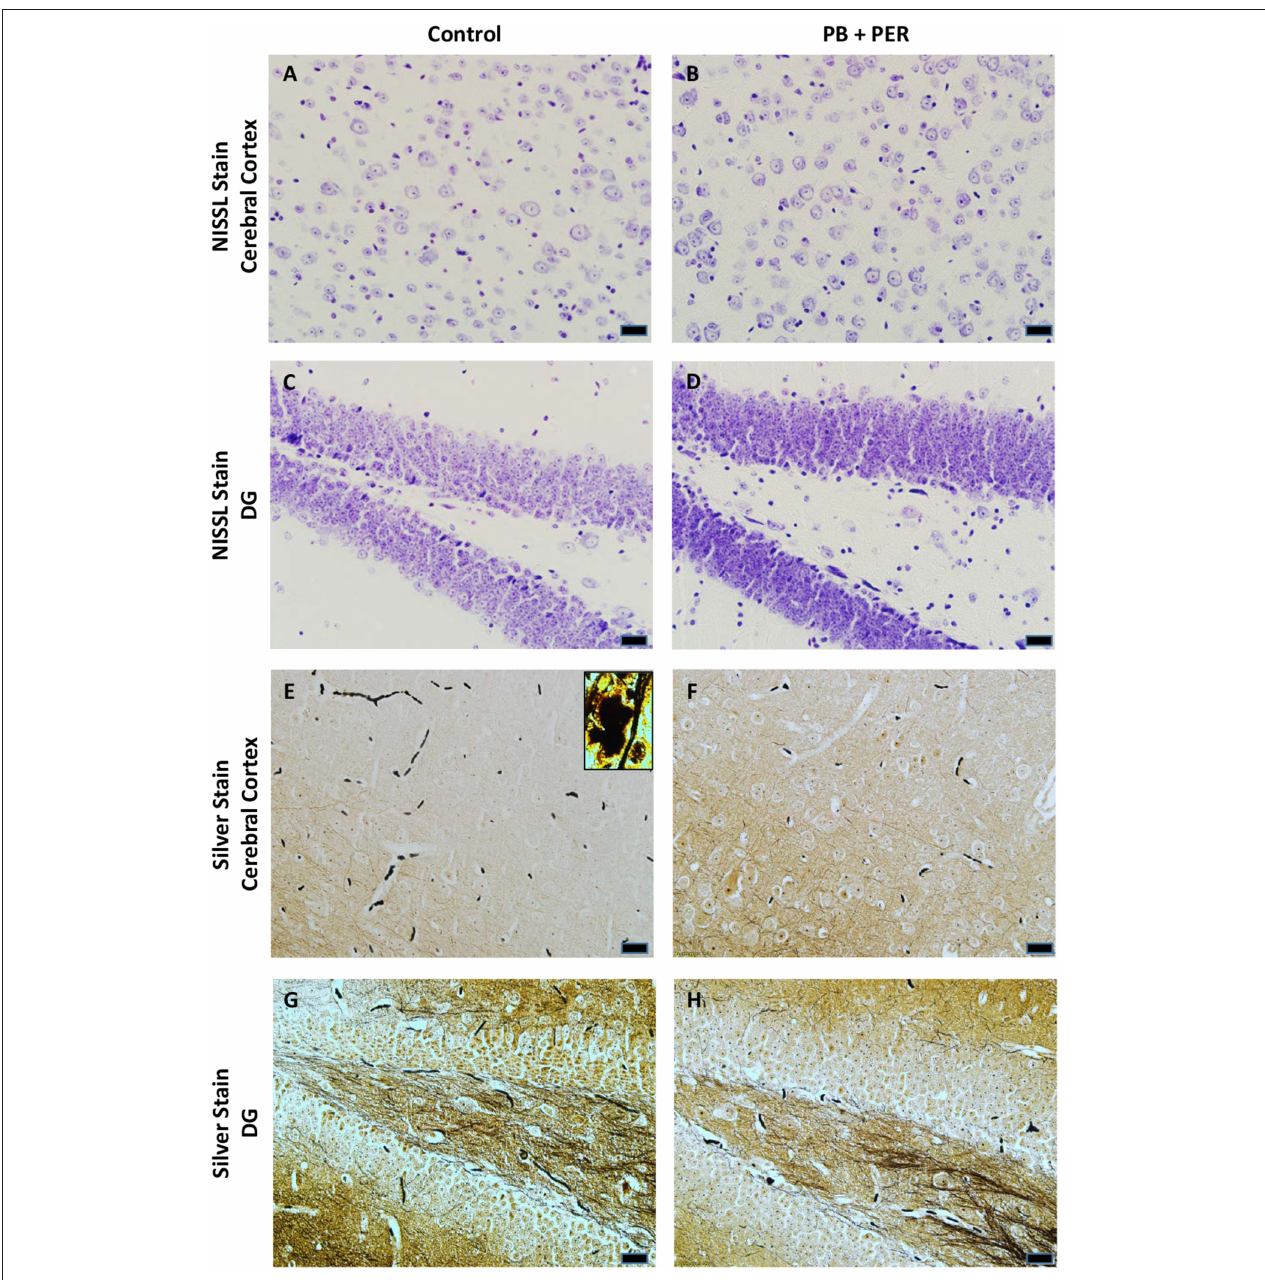
FIGURE 12 | No alterations in cell morphology detected 22.5 months post exposure to PB + PER. Nissl staining revealed no gross morphological changes in nuclei/cell body of pyramidal neurons post exposure to PB + PER (A–D) . Similarly, the majority of cells in the hippocampi and cerebral cortices of PB + PER exposed mice (F,H) as compared to controls (E,G) were free from damaged and swollen axons and degenerated neurons when compared to a positive control (PSAPP mouse model of Alzheimer’s Disease; see inset in E ). Representative images were taken at 40X magnification (scale bar represents 20 µ m).